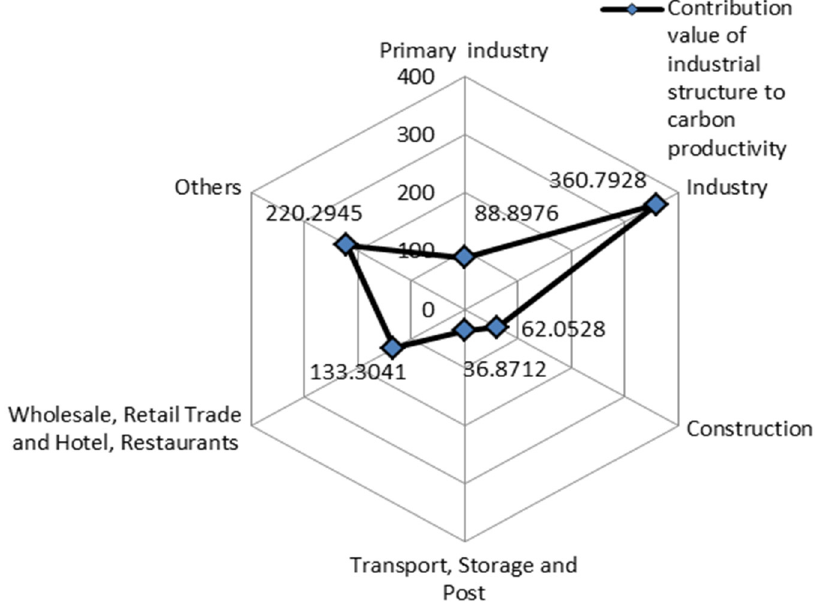
Figure 10. Contribution of industrial structure to the carbon